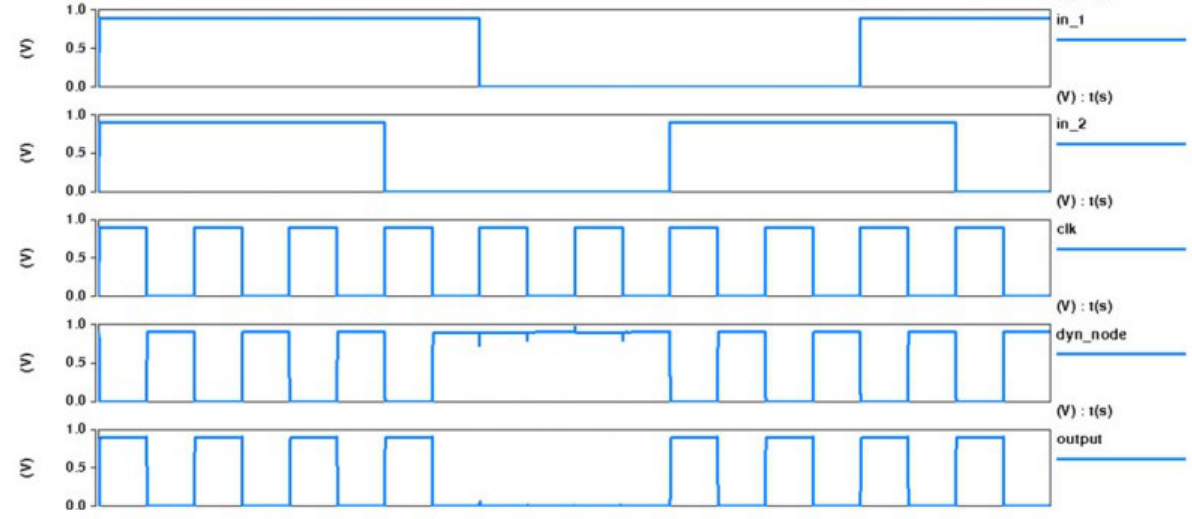
Figure 10. Transient waveforms of a two-input OR gate implemented using the proposed SRLC technique in FinFET technologyat a clock frequency of 100 MHz.